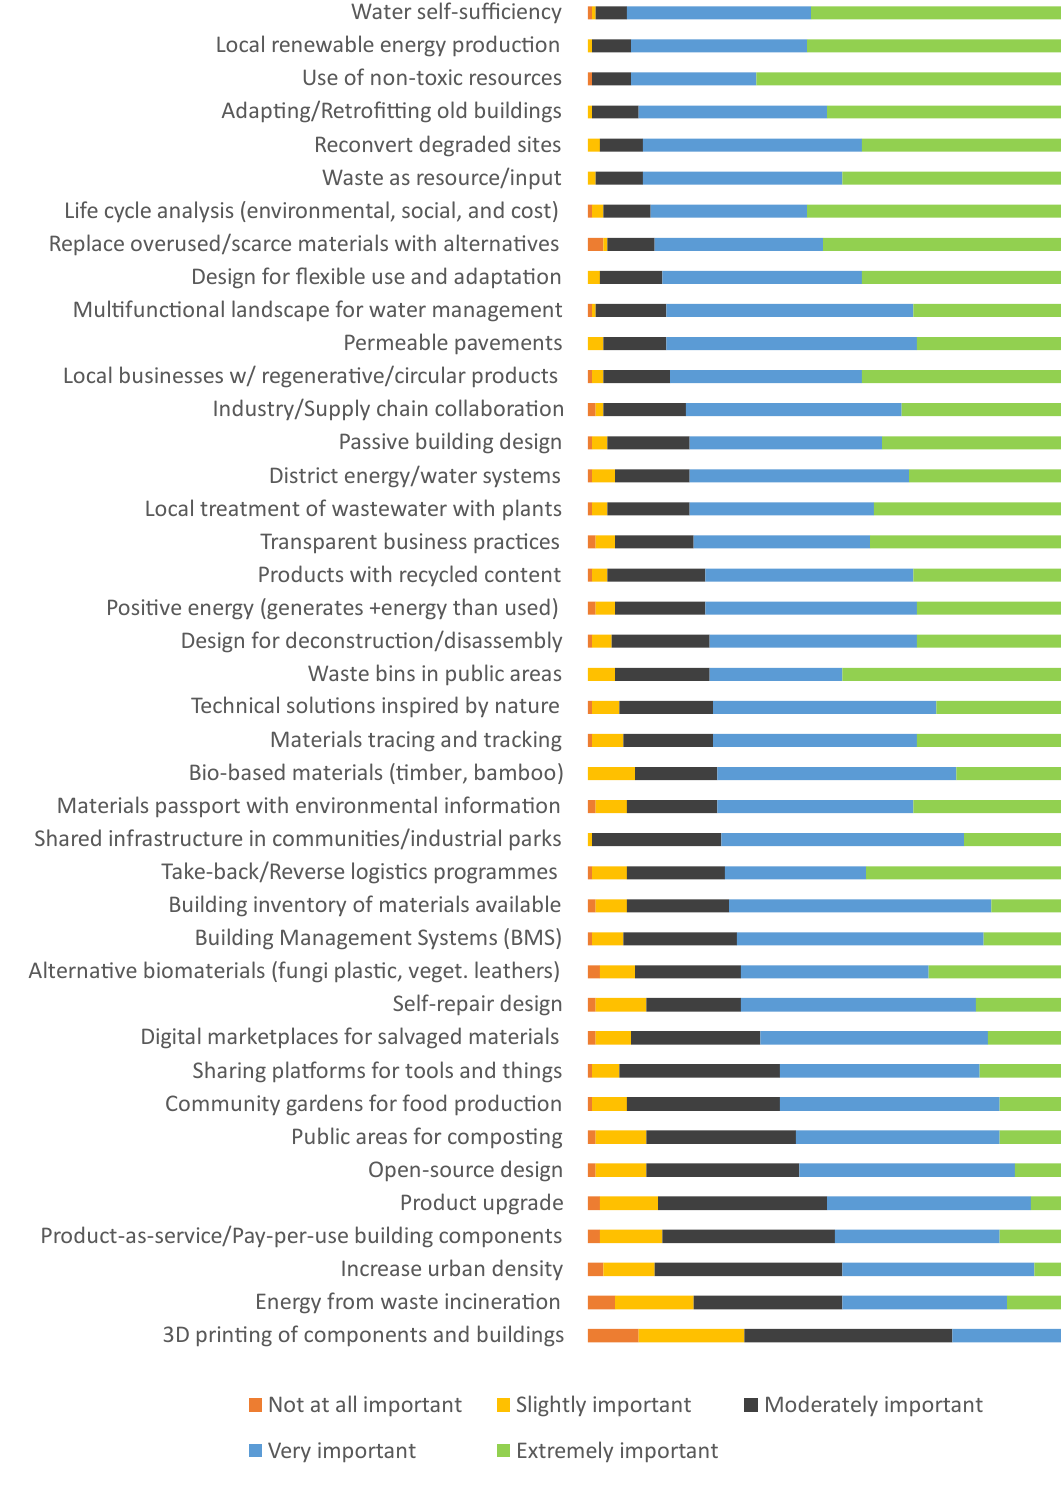
Figure 14. Perception of importance of strategies for a regenerative and circular management and use of resources.